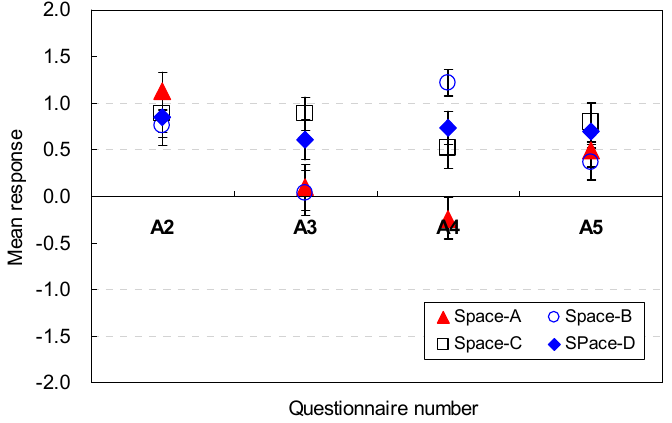
Figure 5. Spatial perception of the spatial size in terms of amenity under height changes.